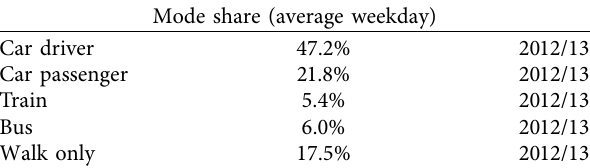
Table 1: Resident travel patterns, Sydney